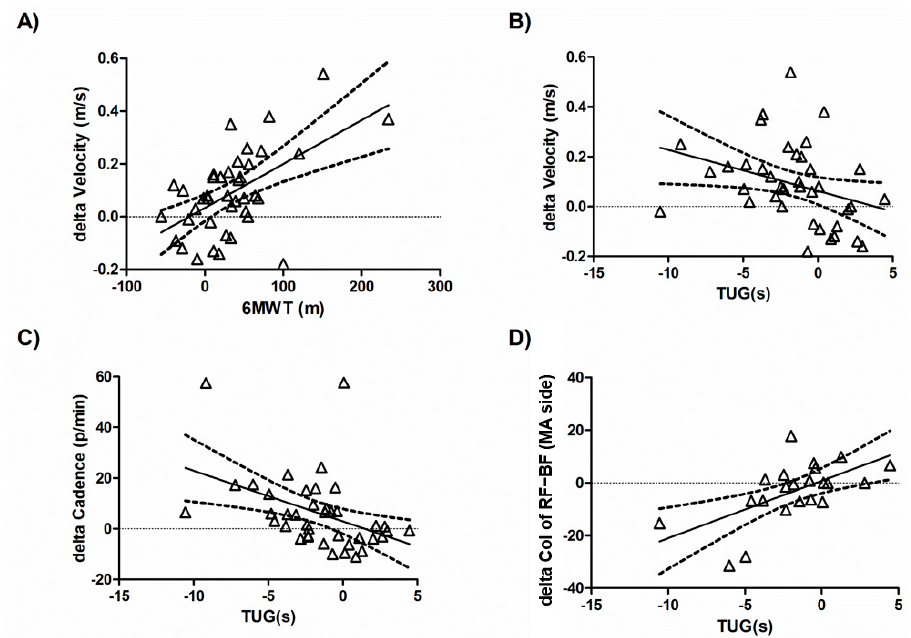
Figure 4. Correlation between changes in the clinical mobility assessments and those of the in- strumental gait parameters from the sEMG and kinematic analyses. Positive delta values indicate post-rehabilitation increase with respect to the baseline. The improvement of 6MWT was positively correlated with velocity improvement ( A ). The TUG improvement correlated with increased velocity ( B ), cadence ( C ), as well as a decreased CoI of the RF–BF MA side ( D ). 6MWT (6-min Walk Test); TUG (Timed Up and Go Test); CoI (co-activation index); RF–BF (Rectus Femoris and long head of Biceps Femoris